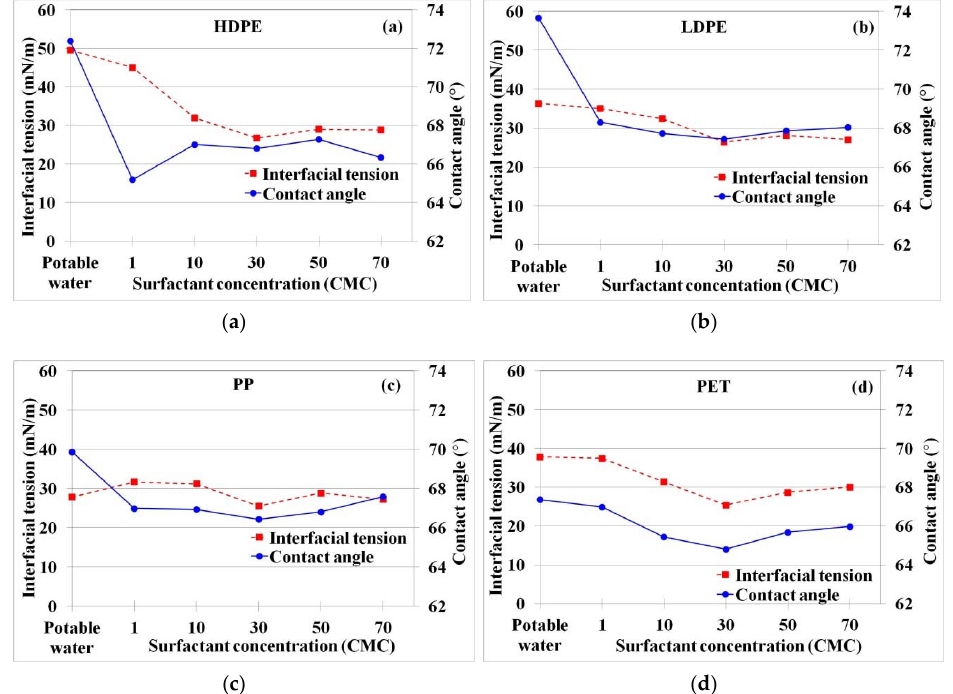
Figure 2. Change of interfacial tension and contact angle at various surfactant concentrations; ( a ) high density polyethylene (HDPE), ( b ) low density polyethylene (LDPE), ( c ) polypropylene (PP), and ( d ) polyethylene terephthalate (PET) fibers.